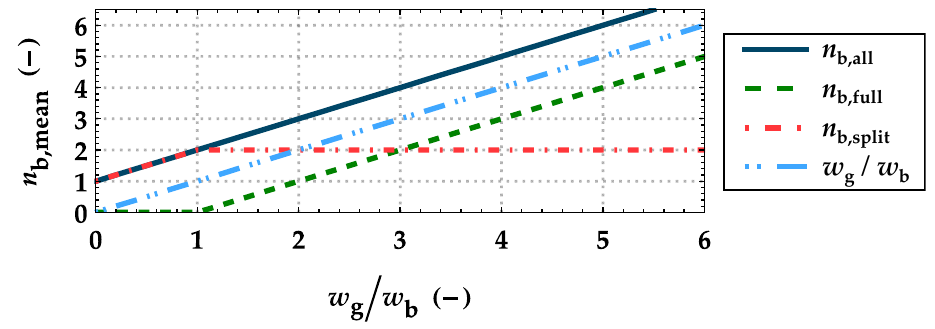
Figure 29. Average numbers of boards acting in parallel in the bending–tension zone of flex_GLT type B beams in dependence on the width ratio w g / w b : total number of boards ( n b,all ); number of boards in full cross-section ( n b,full ); number of lengthwise split boards ( n b,split ).